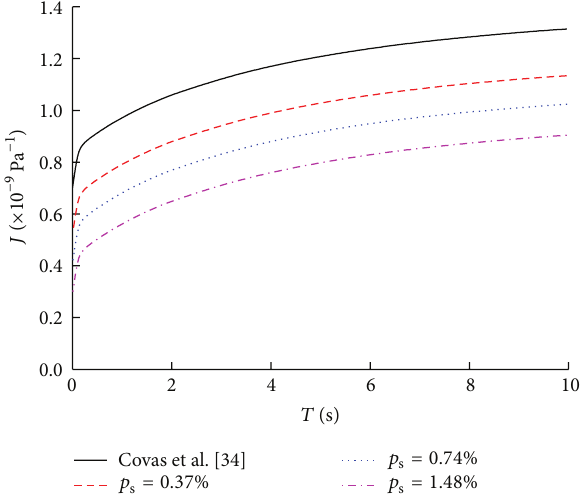
Figure 10: Modified creep function for PE pipe with steel mesh.